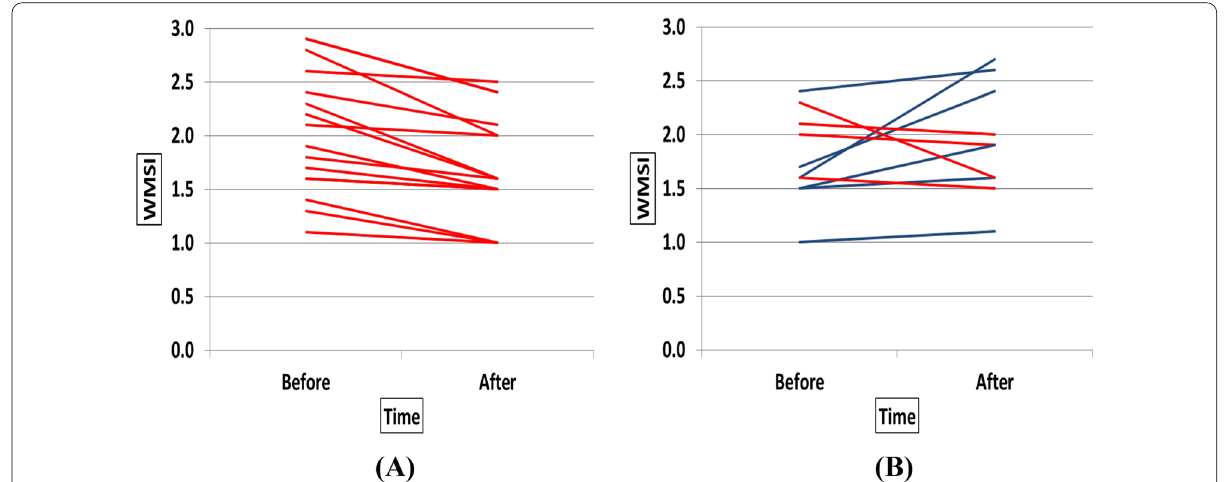
Fig. 2 WMSI in individual patients of TG ( A ) vs. CG ( B ) before and after the study (Red lines were for cases with improved WMSI)